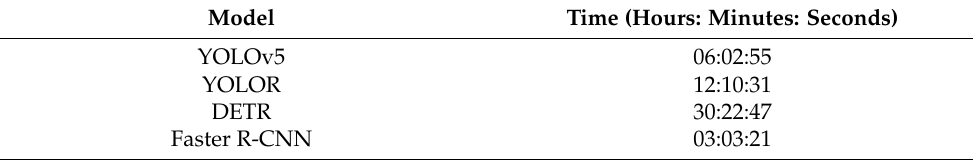
Table 3. Training times of selected DL models.